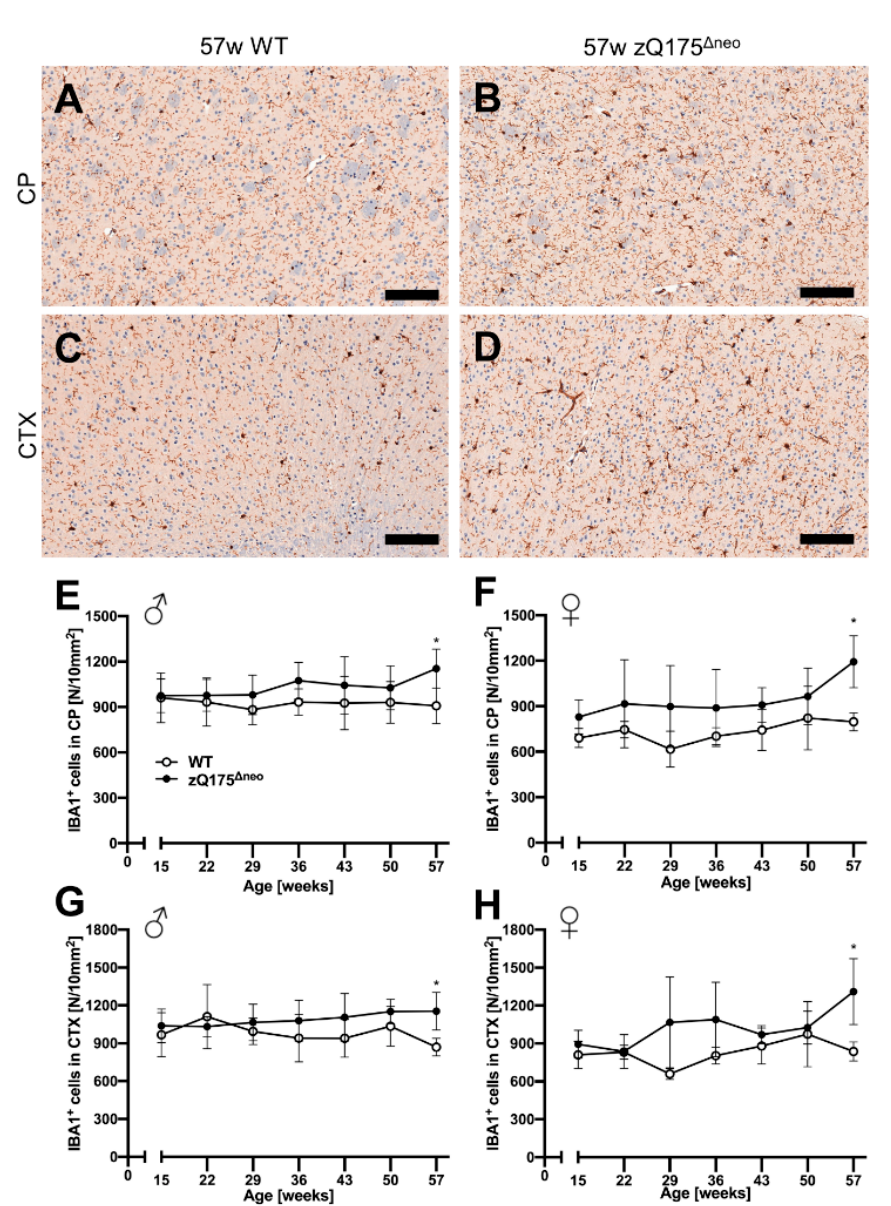
Figure 9. Slight microgliosis was only observed in the caudate-putamen (CP) and cortex (CTX) of zQ175 ∆ neo mice at 57 weeks of age compared to WT littermates. ( A – D ) Coronal brain sections from 57-week-old WT and zQ175 ∆ neo mice were immunohistologically stained against IBA1. Representa- tive images of the IBA1-stained CP ( A , B ) and CTX ( C , D ) of a 57-week-old female WT ( A , C ) and a zQ175 Δ neo mouse ( B , D ). The scale bars indicate 50 µm. Male ( E , G ) and female ( F , H ) zQ175 Δ neo mice ( ● ) show a significant increase of IBA1-positive microglia as compared to WT littermates ( ○ ) in both CP ( E , F ) and CTX ( G , H ) earliest at 57 weeks of age. Data are presented as mean ± SD; N = 5–6. Significance was calculated using two-way ANOVA with Bonferroni’s multiple comparisons test and is given as *: p ≤ 0.05.